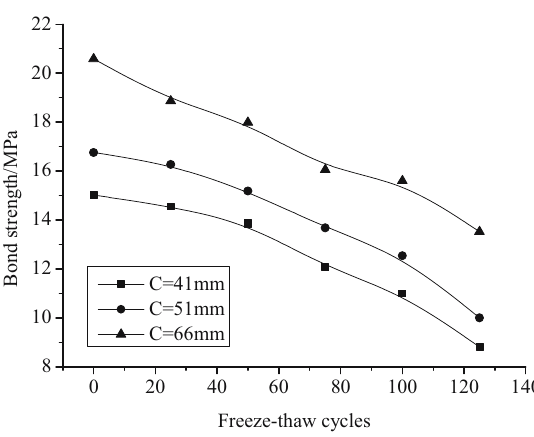
Figure 5: Bond strength of the RAC specimen with di ff erent cover thicknesses.